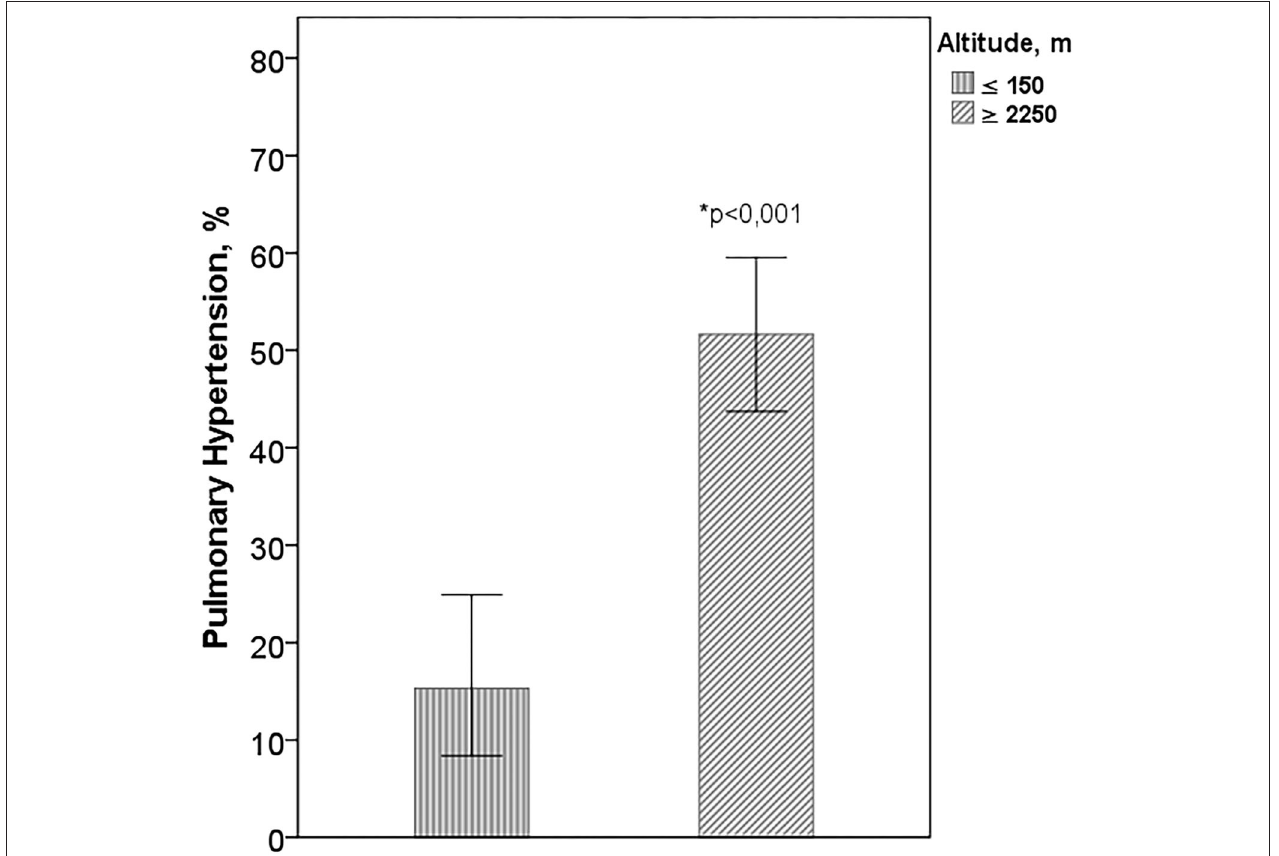
FIGURE 4 | Pulmonary hypertension according to altitude. Altitude: ≥ 2,250m Mexico City and Bogotá; ≤ 150 m: Buenos Aires, Lima, and Trujillo. *Difference between the cities of higher altitude with those of sea